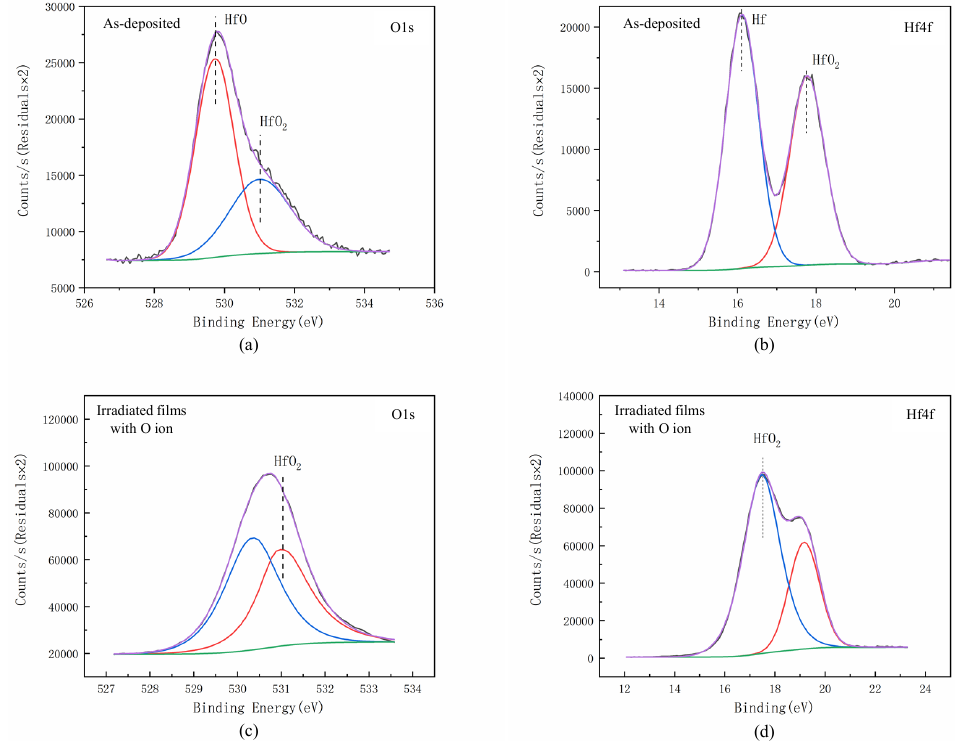
Figure 3. Comparison of XPS patterns of HfO 2 films before and after O ions treatment at an ion energy of 1000 eV; ( a ) O1s spectra of as-deposited films; ( b ) Hf4f spectra of as-deposited films; ( c ) O1s spectra of irradiated films; and ( d ) Hf4f s spectra of irradiated films.